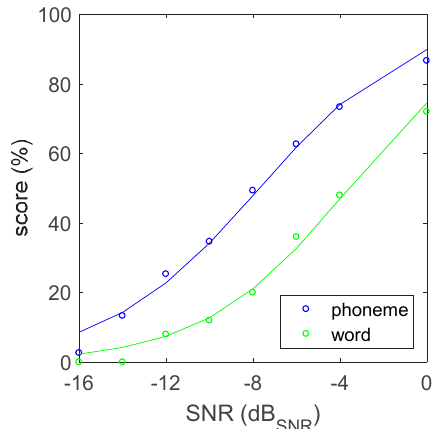
Figure 4. Reference speech recognition curve in speech-shaped noise. Experimental data (dots) and curve fit (line).